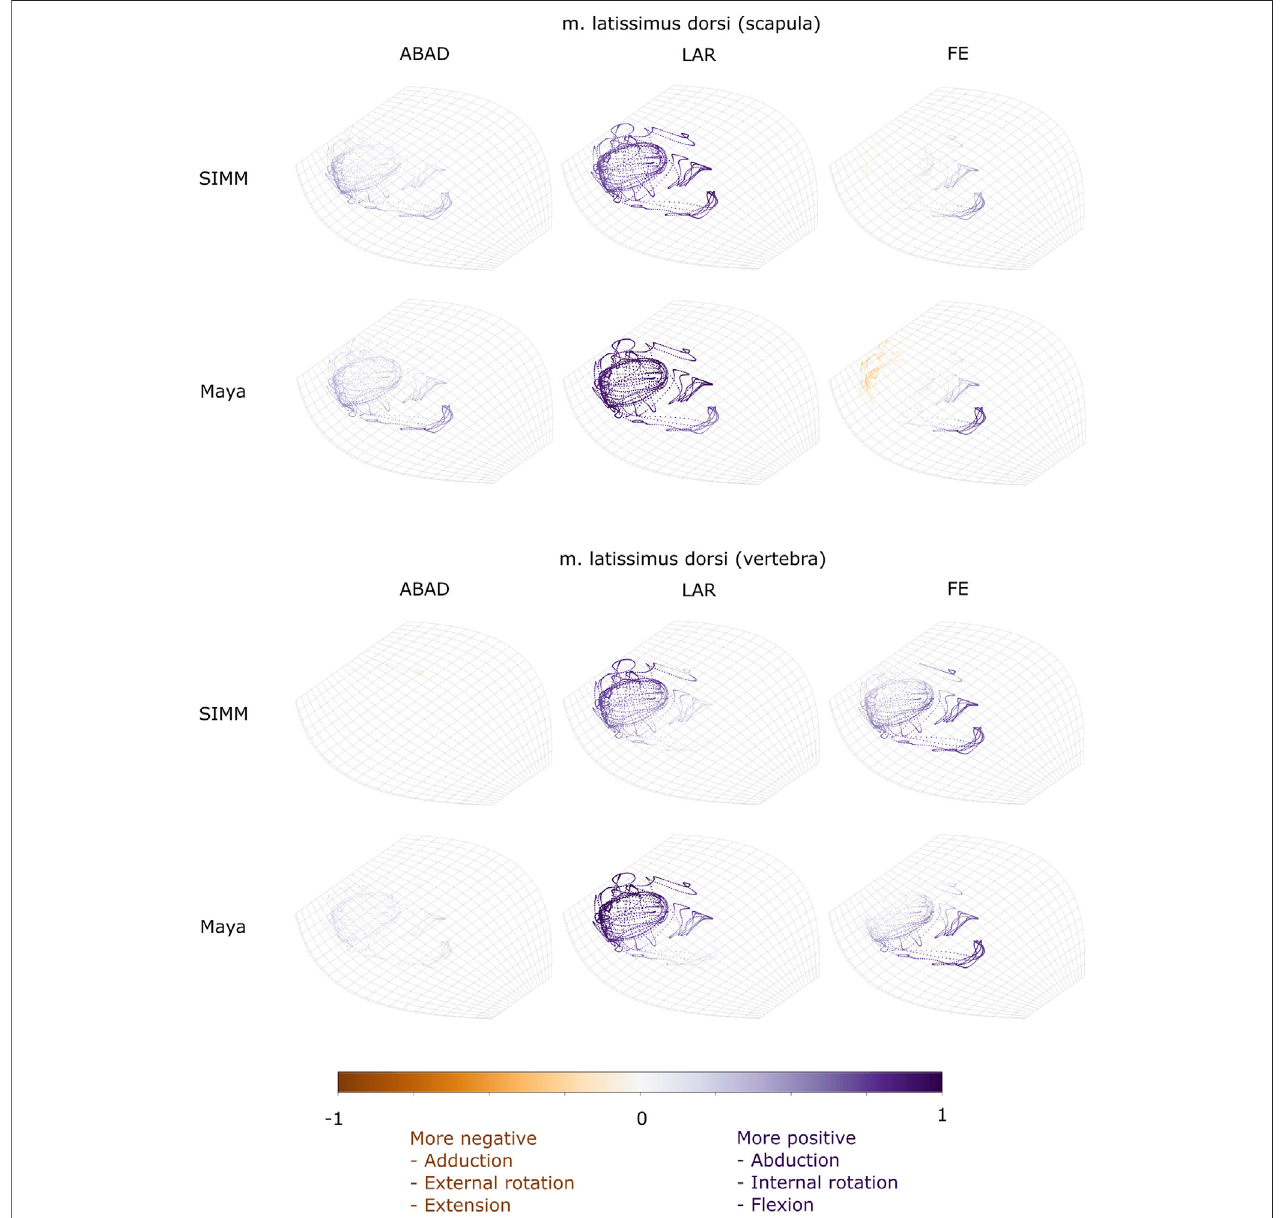
FIGURE 7 | Three-dimensional (3D) MMAs of m. latissimus dorsi at the glenohumeral joint, plotted in cosine-corrected ROM space for the SIMM model (using partial velocity) and Maya experimental data (usingthe geometric method). MMA sign isindicated bypoint colour (positive values are purple, negative values are orange) with colour intensity scaled to relative MMA magnitude as described in the Methods. ABAD (cid:3) abduction-adduction; LAR (cid:3) long-axis rotation (internal-external rotation); FE (cid:3) fl exion-extension.